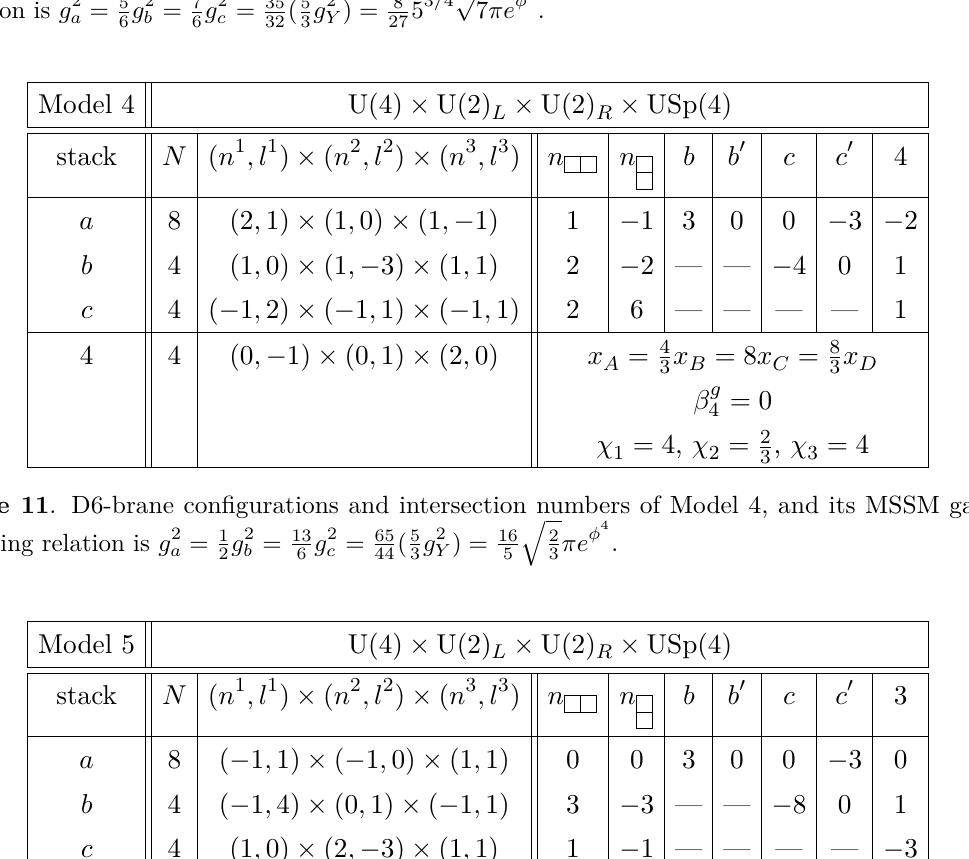
Table 10 . D6-brane configurations and intersection numbers of Model 3, and its gauge coupling